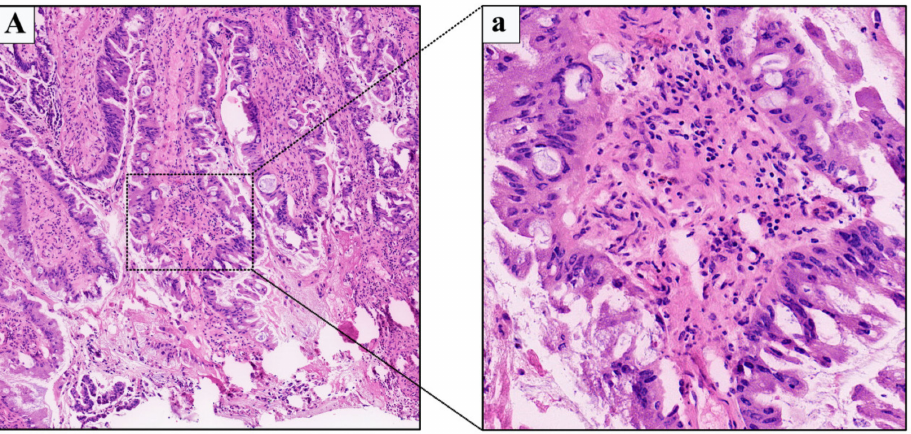
Figure 2. Primary female urethral adenocarcinoma of the Case 2 in 2010. Low-power (( A ), 4 × 10 magnification) and high-power (( a ), 40 × 10 magnification) view showing adenocarcinoma of the urethra with mucinous